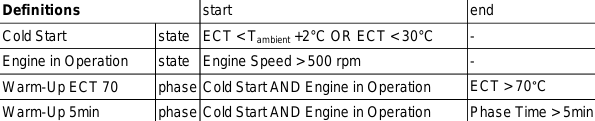
Fig. 2. Definition of warm-up in RDE-test